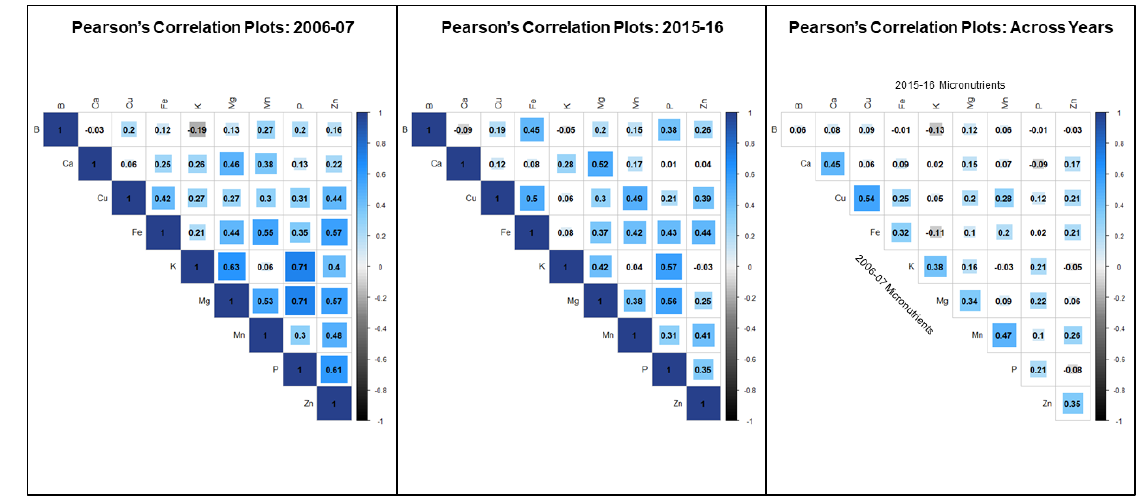
Figure 2. Pearson’s correlation plots. ( left ) looks at the relationship between traits from 2006–07 samples. ( middle ) looks at the relationship between traits from 2015–16 samples. ( right ) looks at the relationship between traits from across years samples.